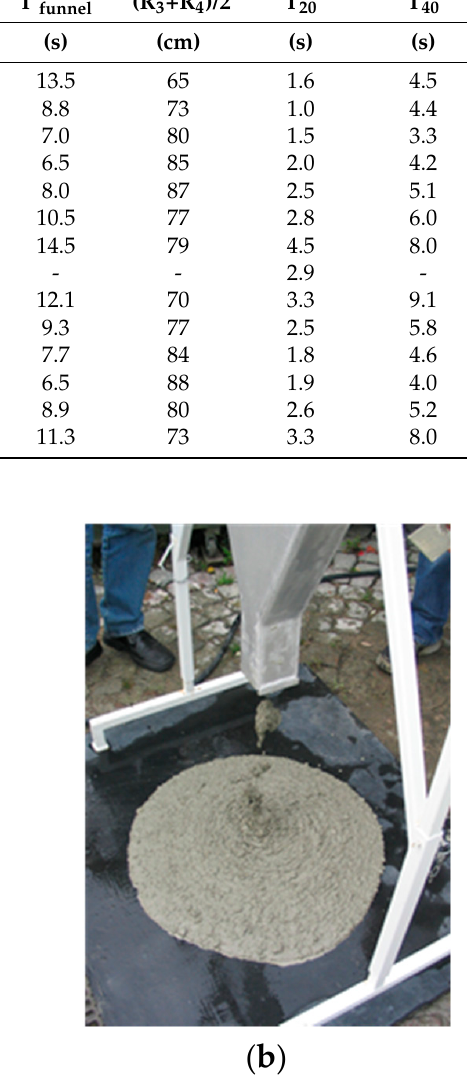
Figure 8. Analysis of self-compacting and flow dynamics performed using the L-box ( a ) and the V-funnel ( b ).